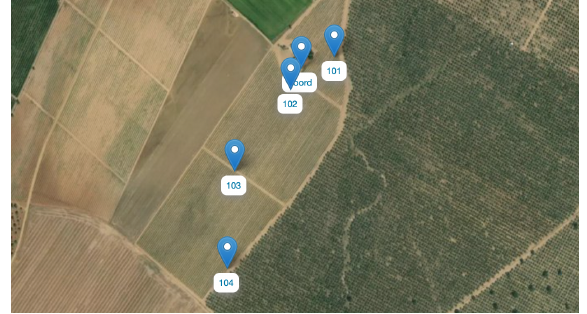
Figure 8. Diagram of the network deployed in Farm